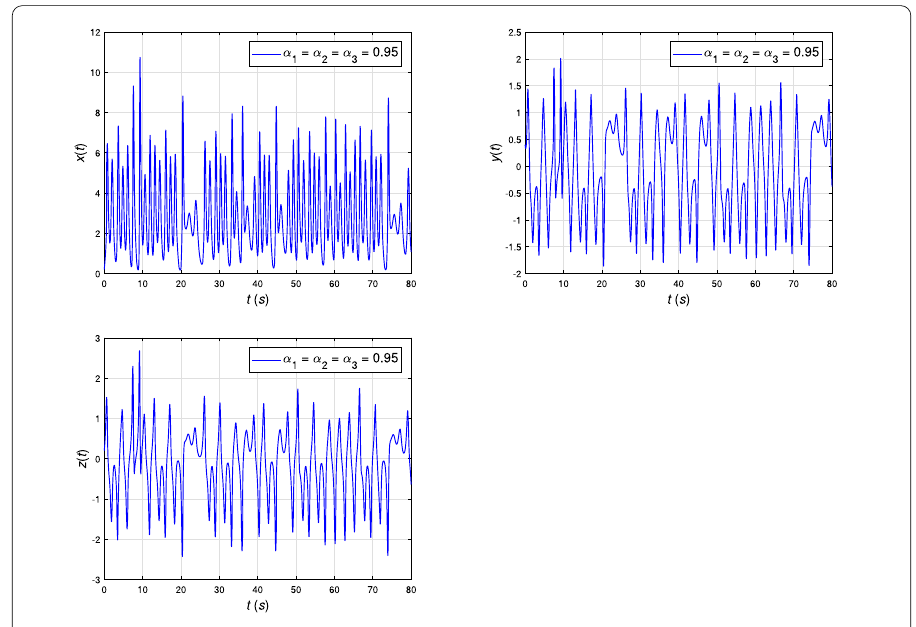
Figure 5 State variables of the fractional-order model (21) in the time-domain ( α i = 0.95, i = 1,2,3)